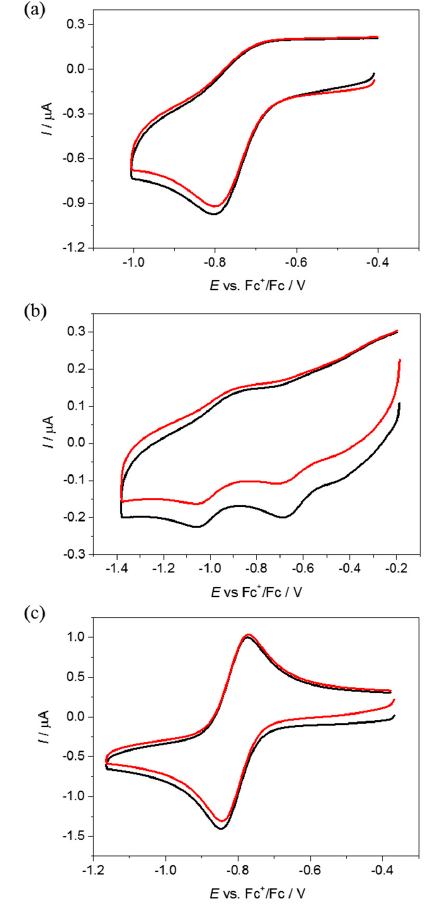
Figure 5. Cyclic voltammograms of 0.5 mM ( a ) of 1 , ( b ) 2 and ( c ) 3 in DMSO / n- Bu 4 NPF 6 at a scan rate of 100 mV s –1 (black traces represent the first scan, while red traces the second